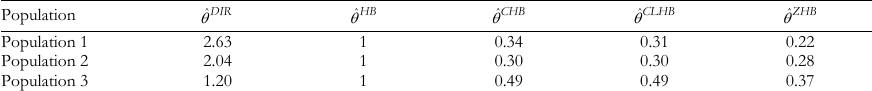
Ratio of the Anderson-Darling distances between estimated and actual EDF averaged over MC replications divided by the same quantity calculated for the ˆ HB  estimators, i.e.